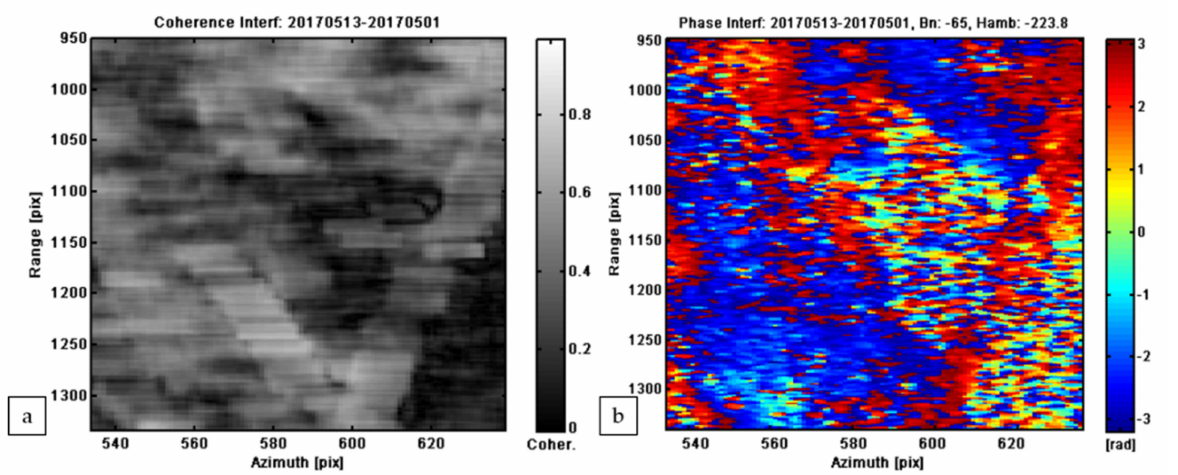
Figure 10. Coherence ( a ) and phase ( b ) of the last available interferogram (number 59 in Figure